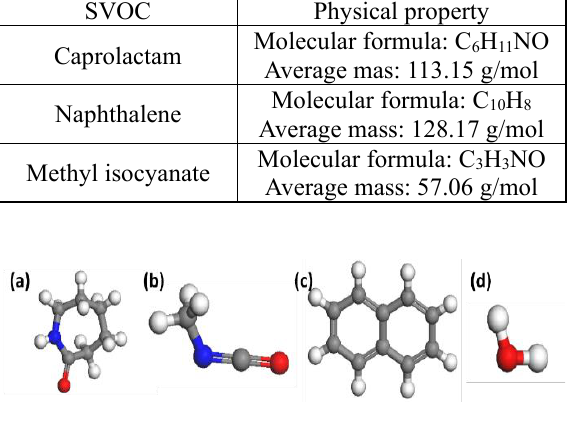
Figure 2. The molecular structures